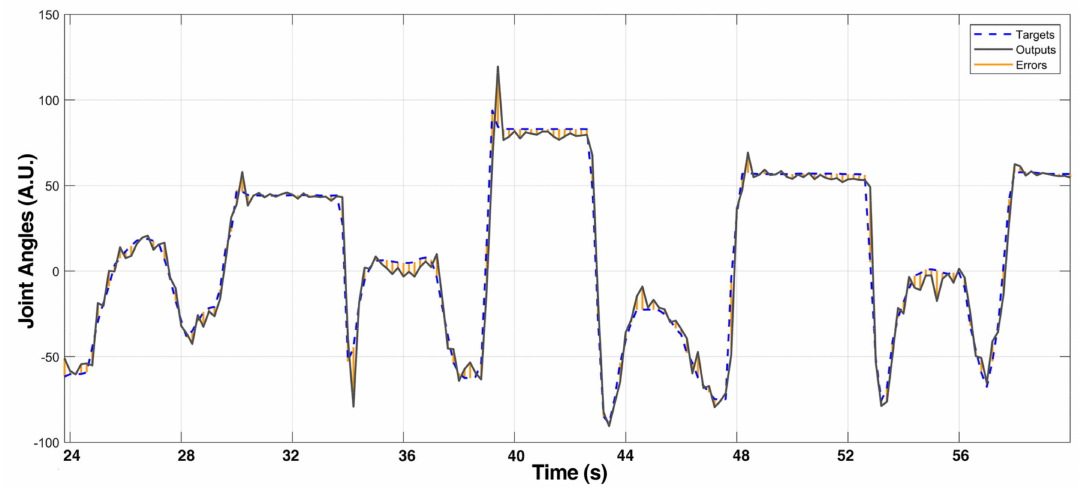
Figure 15. Comparison of NARX model output and the target in daily movements.